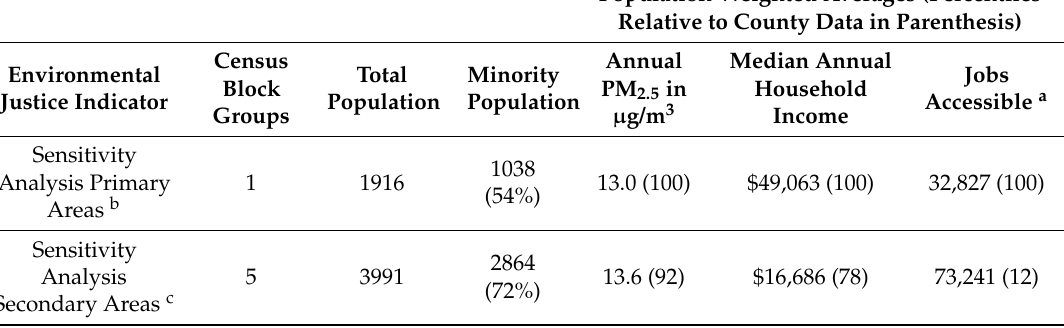
Table 2. Summary of primary and secondary census block groups identified as environmental justice priority areas by sensitivity analysis for a minority variable cut